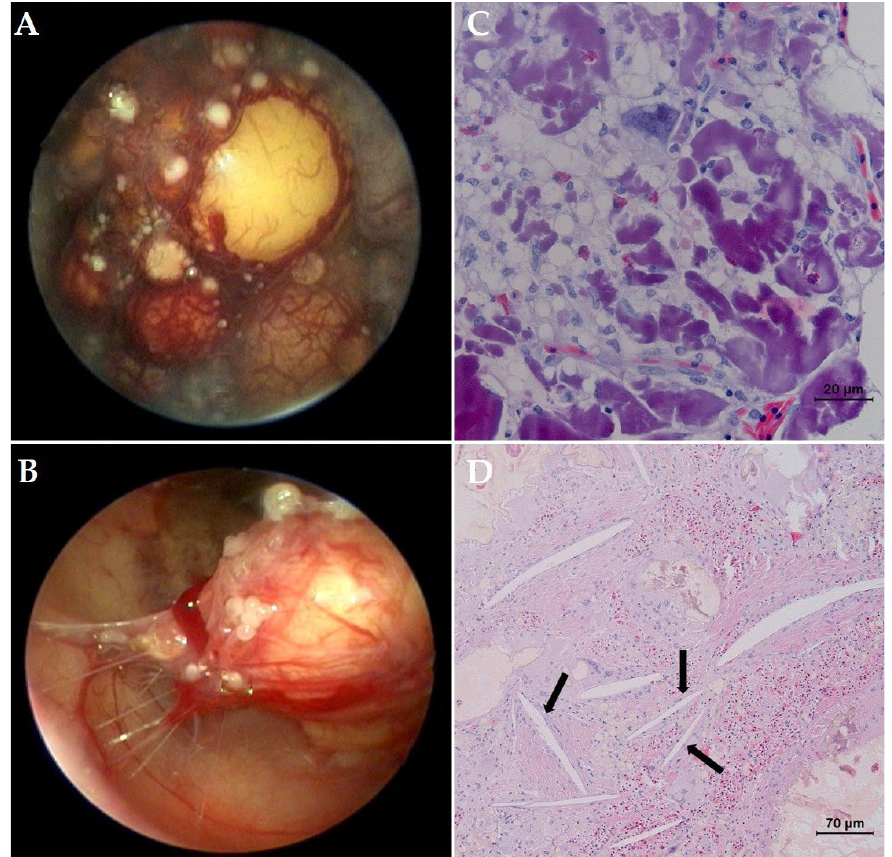
Figure 3. ( A ). Left prefemoral coelioscopic view of the left ovary in a common snapping